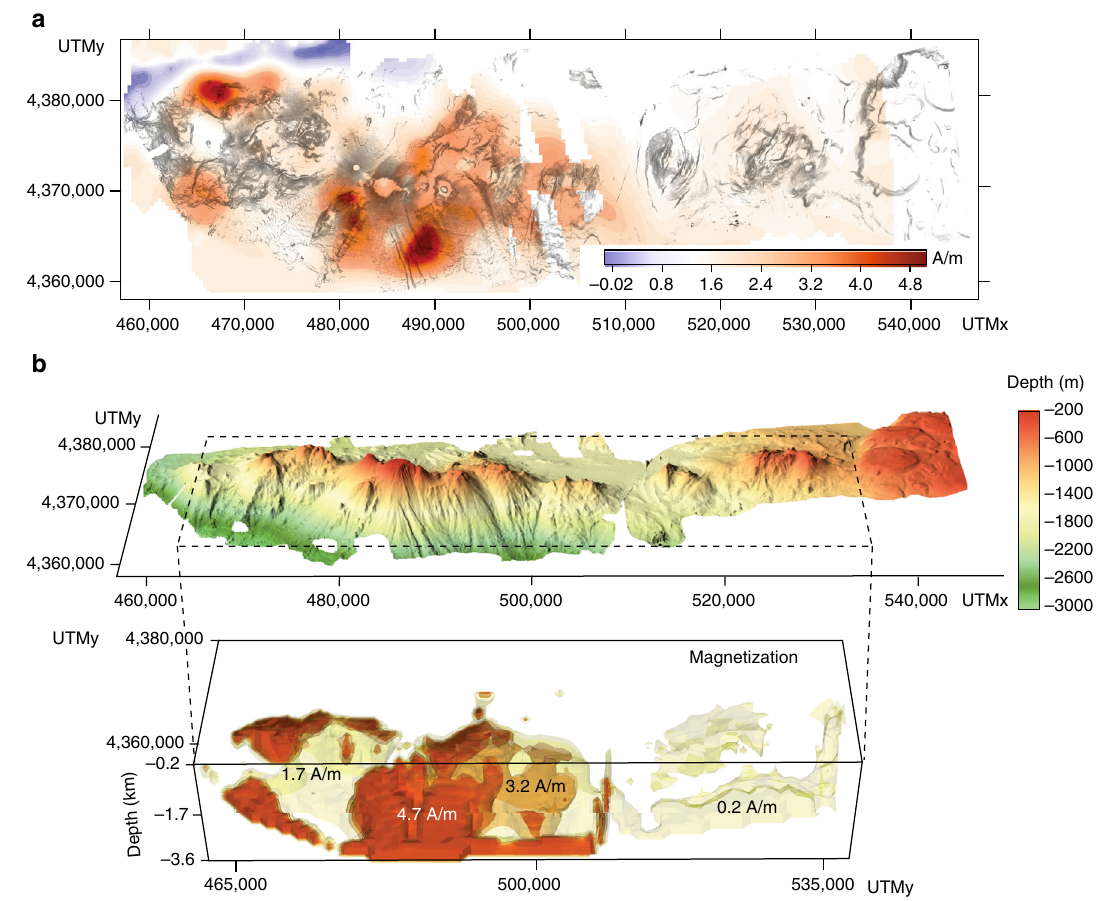
Fig. 7 Results of the inverse models of the magnetic data. a Apparent magnetization intensity map derived from the 2D inversion of the magnetic data draped on the shaded relief bathymetry of the STEP volcanic chain. b 3D view of the STEP volcanic chain and results of the 3D inverse model, perspective view from the